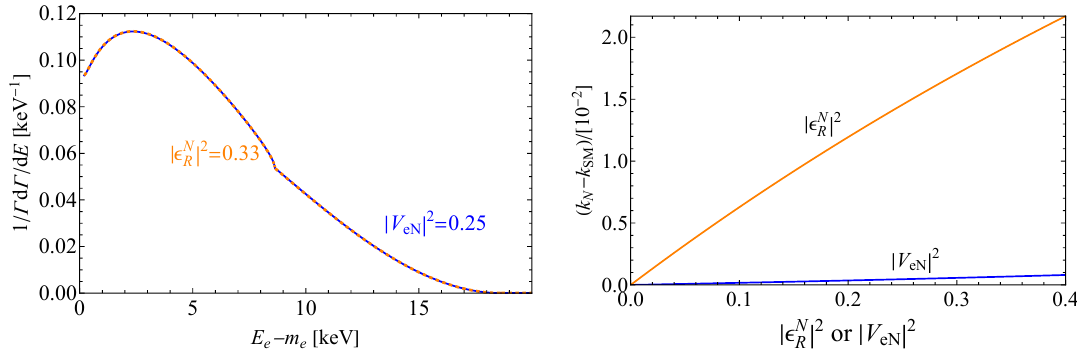
Figure 6 . Energy and angular distributions showcasing the difference between an active-sterile mixing and an exotic right-handed leptonic current for producing a 10 keV neutrino. Left: normalised energy distributions with active-sterile mixing, | V eN | 2 = 0 . 25 (blue, dashed), overlapping with an exotic sterile | (cid:15) N | 2 = 0 . 33 (orange) contribution. Right: deviation of the angular correlation factor R k from the SM value as a function of the active-sterile mixing | V eN | or the right-handed leptonic current parameter | (cid:15) N | R